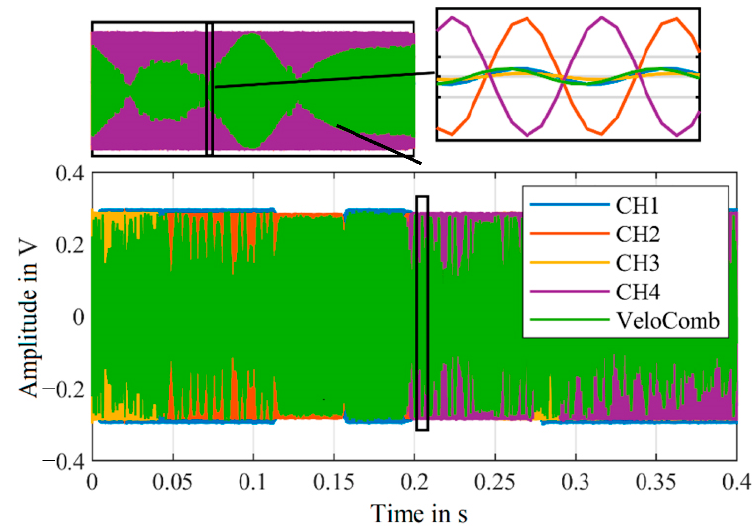
Figure 7. Raw signals of the individual channels and the combined signal (VeloComb) derived from the individual channels and weighting factors from Equation (2).